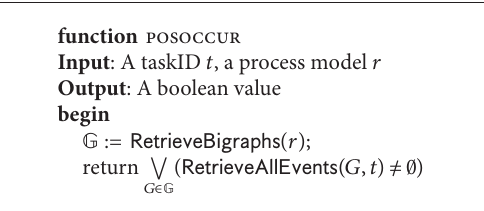
Algorithm 6: Determining the (unary) basic predicate posoccur.